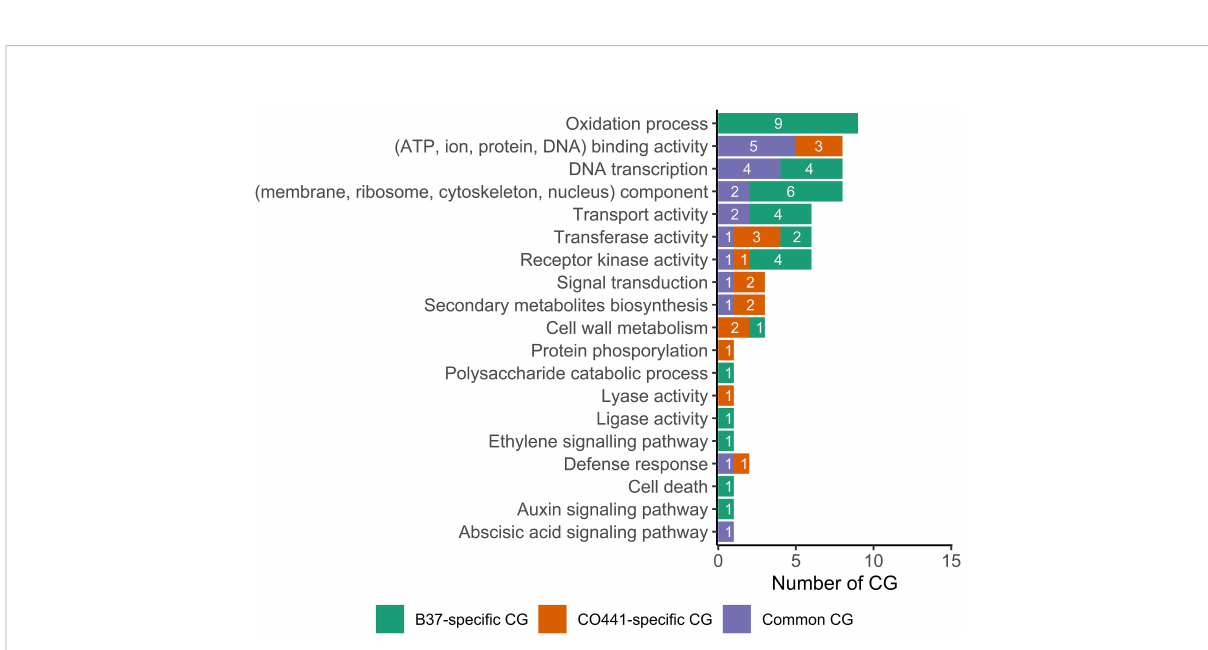
FIGURE 5 Gene ontology terms of the differentially expressed candidate genes (CG) between resistant (CO441) and susceptible (B37) lines under Fusarium graminearum